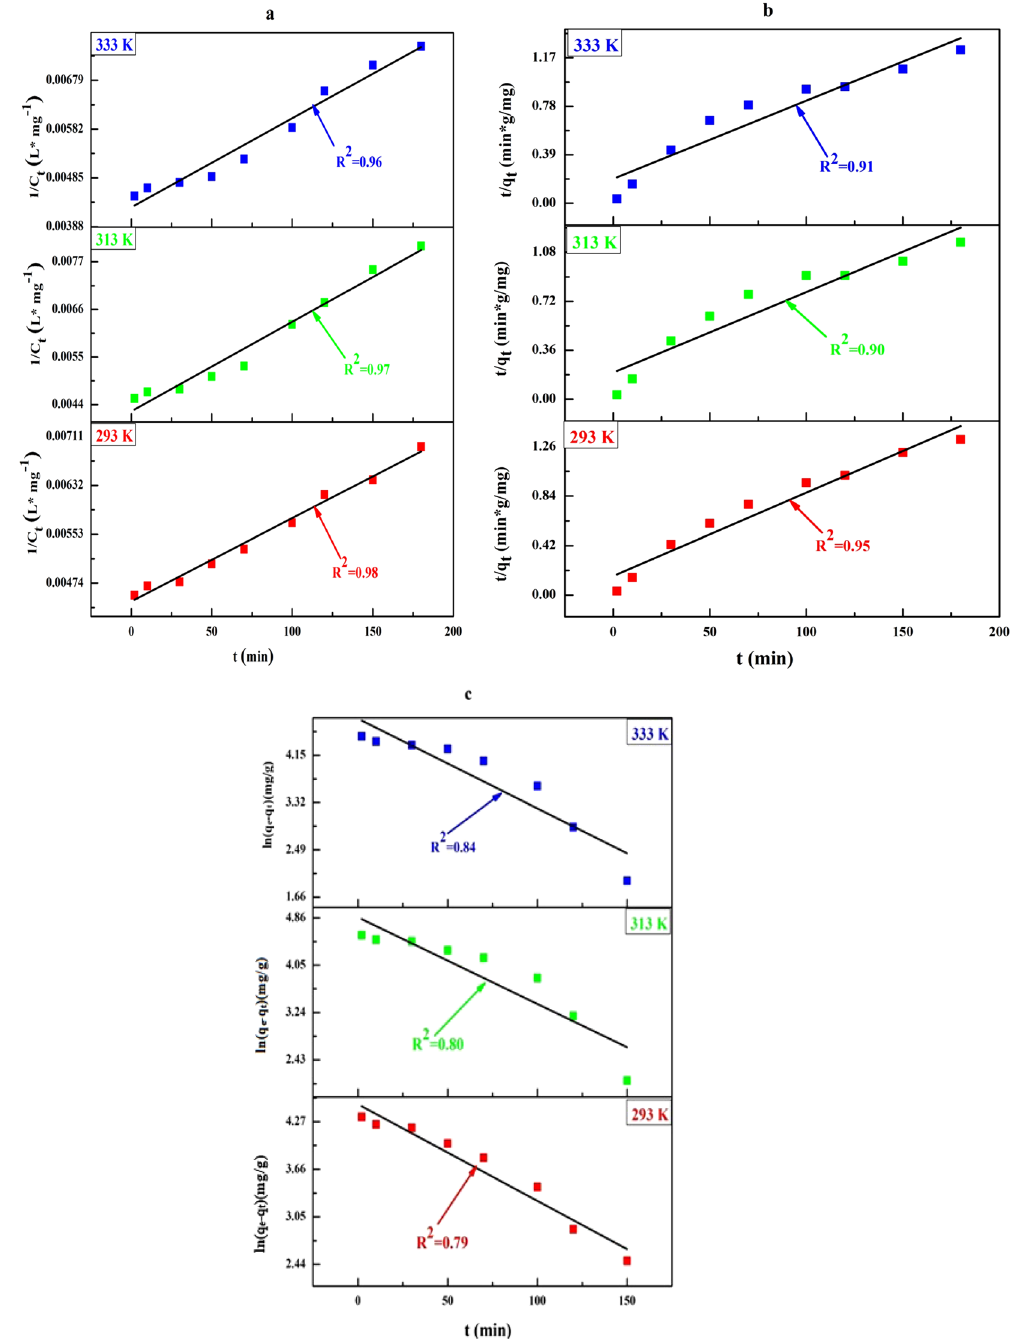
Figure 13. ( a ) Second-order and ( b ) pseudo-second-order ( c ) pseudo-first-order kinetics for adsorption of the Cu (II) ions onto GFLE at 293, 313 and 333